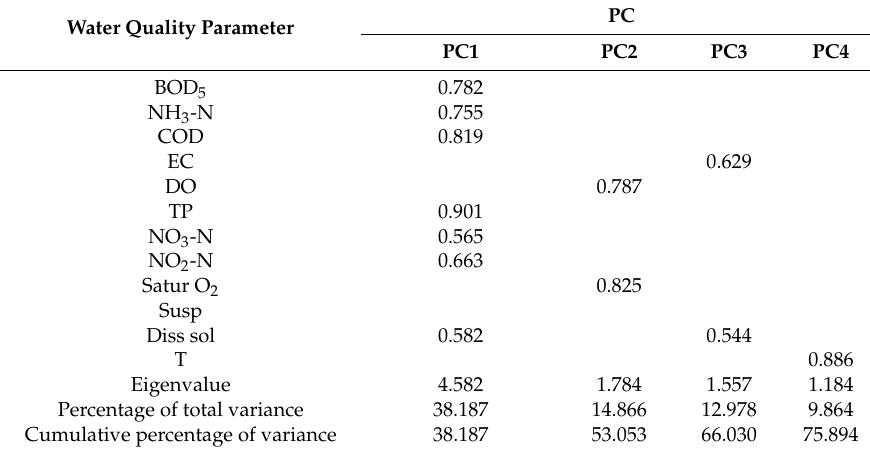
Table 4. Loading on components for water quality